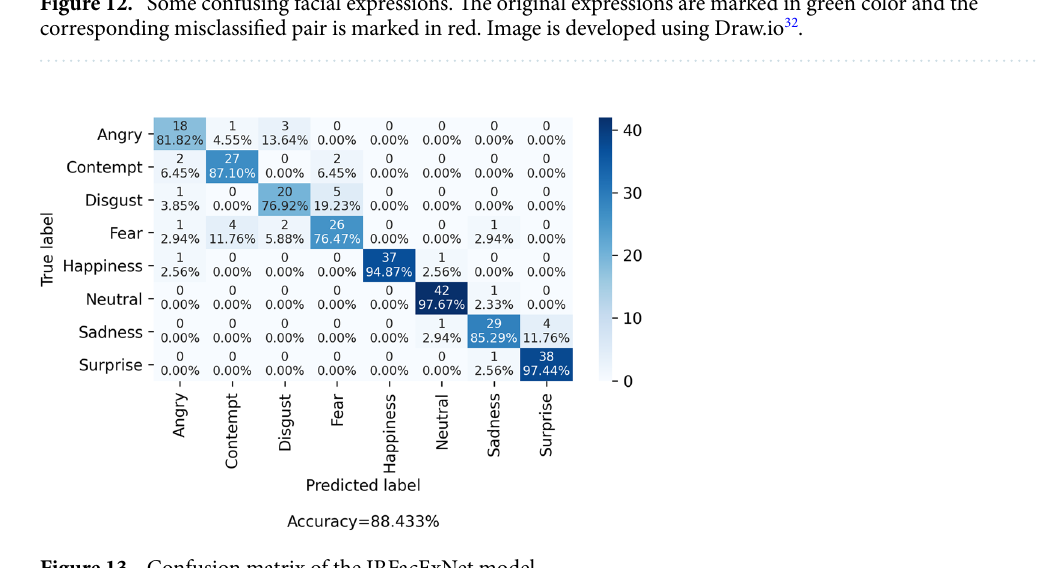
Figure 13. Confusion matrix of the IRFacExNet